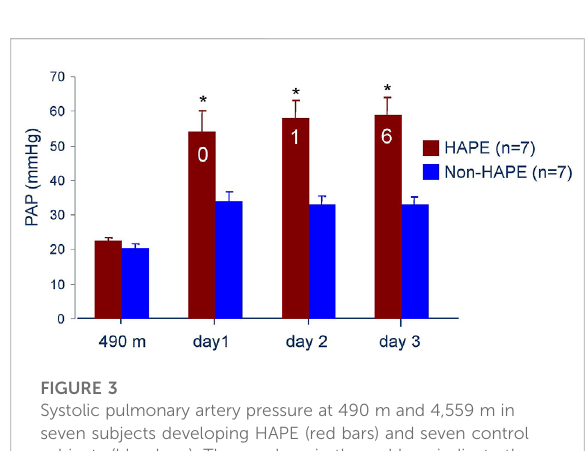
FIGURE 3 Systolic pulmonary artery pressure at 490 m and 4,559 m in seven subjects developing HAPE (red bars) and seven control subjects (blue bars). The numbers in the red bars indicate the subjects with HAPE at a particular examination. Data taken from Bärtsch P. et al., 1991. Prevention of high-altitude